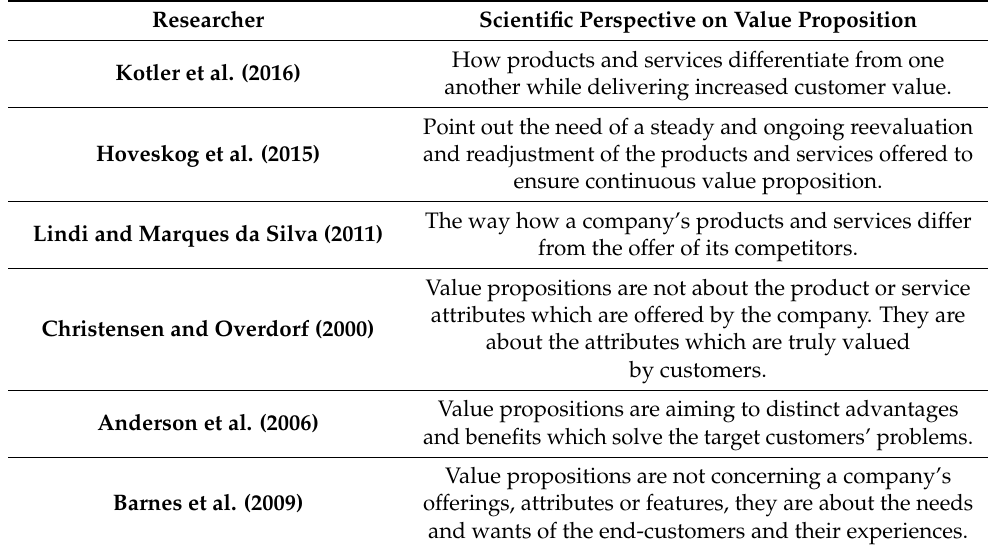
Table 1. Value-proposition perspectives. Source: developed by authors